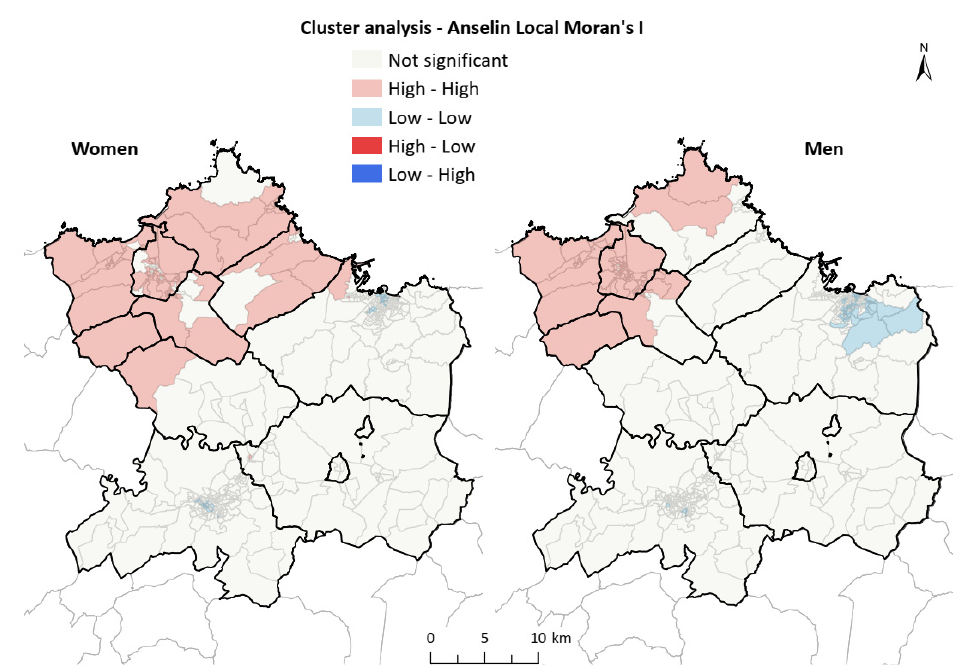
Figure 5. Cluster analysis (LISA) of AMI and AP in the study area. There were high-value grouping areas in the Avilés region (councils of Avilés, Castrillón, Corvera de Asturias, Illas and Gozón) in the case of men, extending to Carreño and Gijón for women. In the case of men, the presence of a group of low values in the central and eastern areas of Gijón was notable.